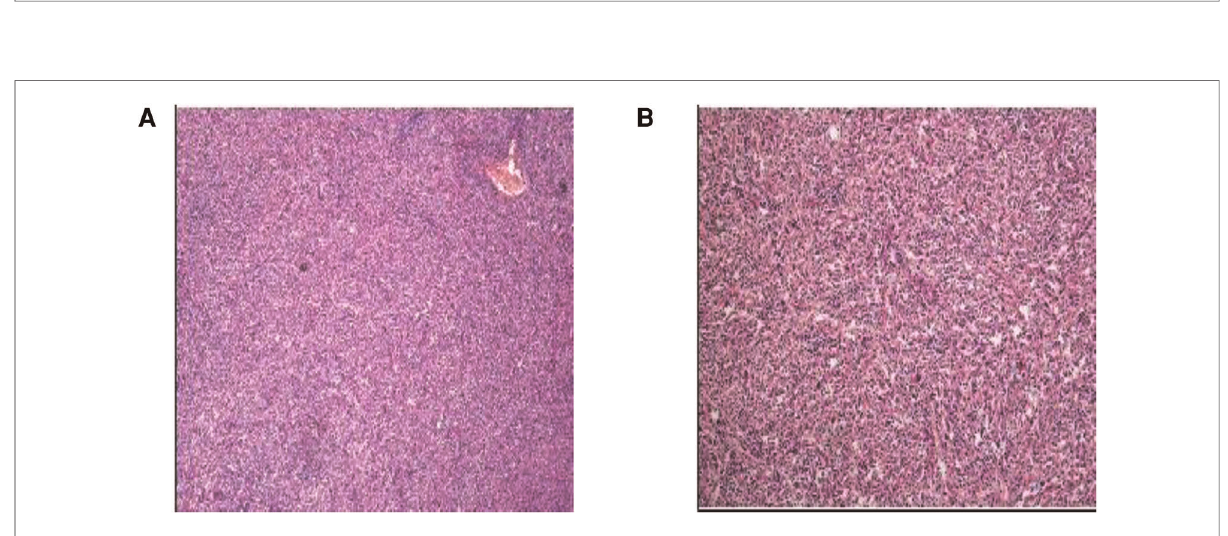
FIGURE 2 Pathological picture of in fl ammatory myo fi broblasts in the liver. A large number of spindle cell proliferation in the liver tissue is seen in the fi